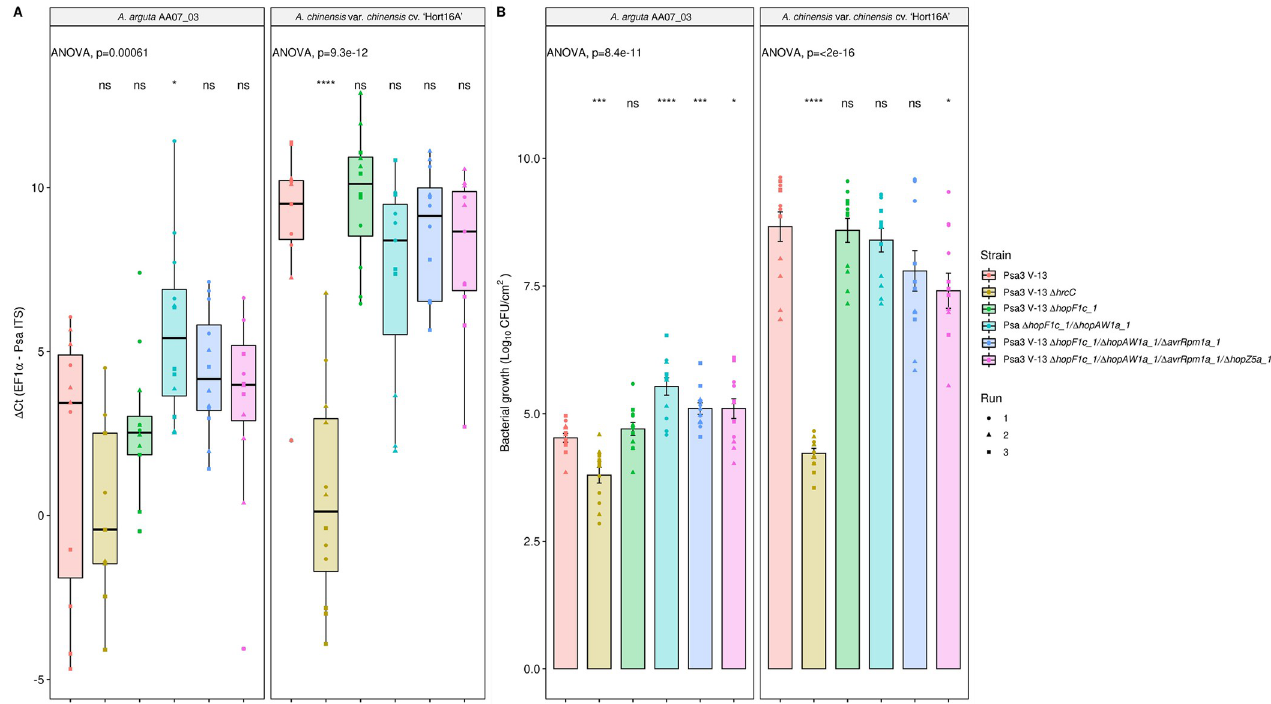
Fig 6. Pathogenicity assay of Psa3 V-13 multiple avirulence effector knockout strains demonstrates lack of increasing resistance-escape due to a cumulative loss of virulence. Actinidia arguta AA07_03 and Actinidia chinensis var. chinensis ‘Hort16A’ kiwifruit plantlets were flood-inoculated at approximately 10 6 cfu/mL. Bacterial growth was quantified at 12 days post-inoculation using qPCR Δ Ct analysis A and plate count quantification B . The experiment was conducted three times (biological replicates) with three batches of independently grown plants and data were stacked to generate the box plots and bar graphs shown. Asterisks indicate significant differences from ANOVA followed by a post hoc Student’s t -test between the indicated strain and wild-type Psa3 V-13, where p � 005 ( � ), p � .001 ( ��� ), p � .0001 ( ���� ), and p > .05 (ns; not significant). (A) Box and whisker plots, with black bars representing the median values, whiskers representing the 1.5 inter-quartile range, and black dots indicating outliers. (B) Bar height represents the mean number of Log 10 cfu/cm 2 and error bars represents the standard error of the mean (SEM) between four pseudobiological replicates.